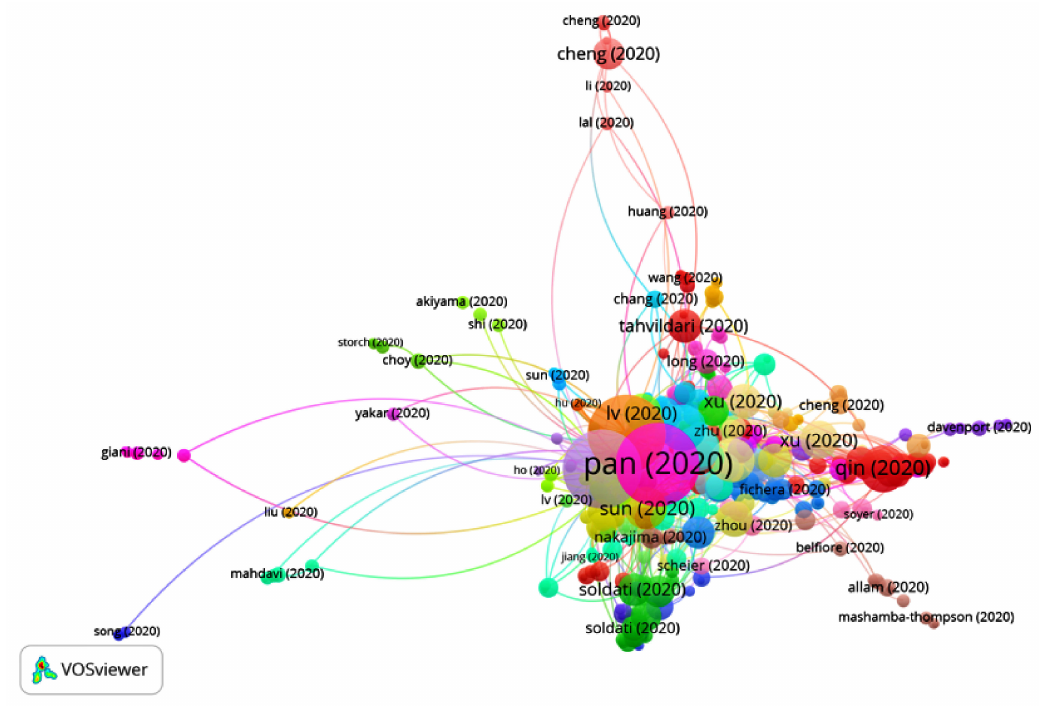
Figure 12. Citation network for Group